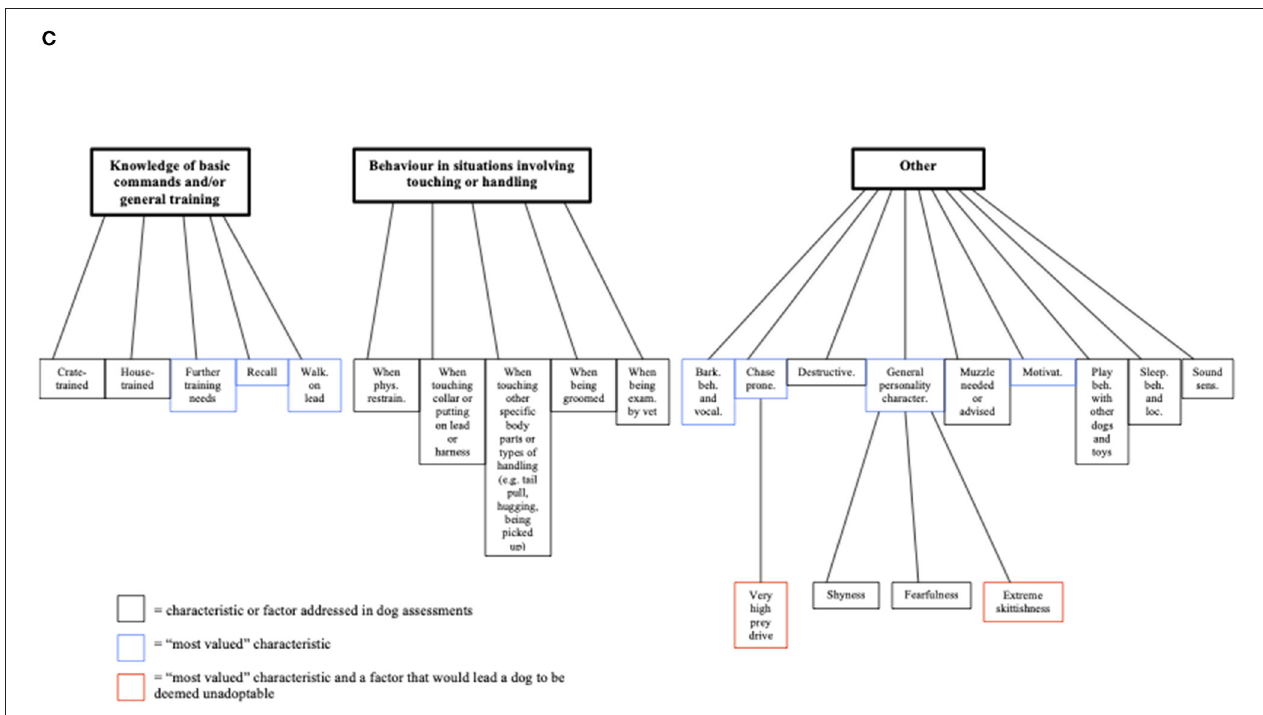
FIGURE 1 | (A–C) Pre-adoption dog assessment themes and sub-themes.